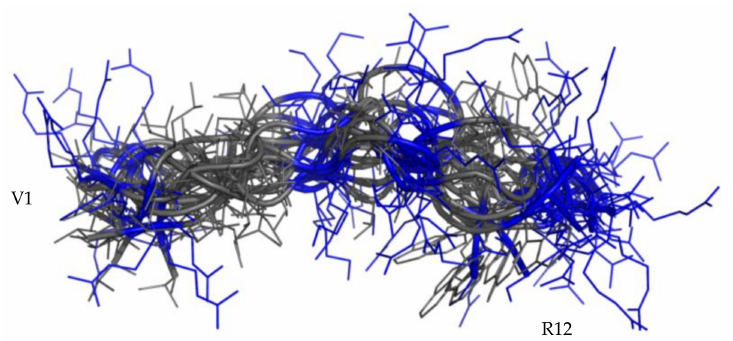
Figure 6. NMR structures of 1018-K6. Superimposition of 17 structures belonging to the main Chimera cluster representative of 1018-K6 conformation in water. Cartoon representation with hydrophobic side-chains as lines colored in gray and positive charged (R, K) in